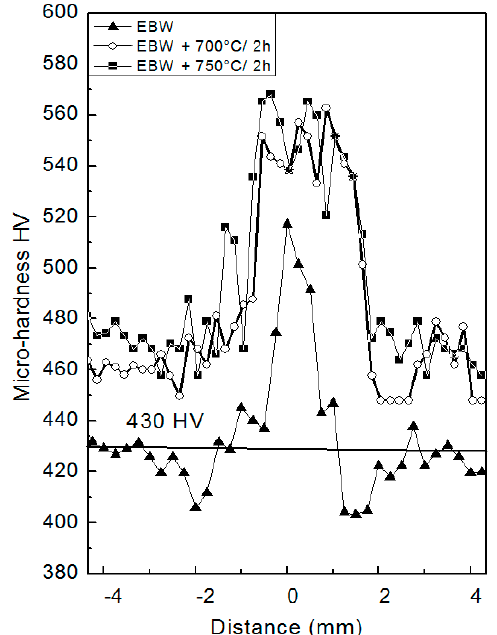
Figure 15. Micro-hardness profiles across a joint realized with PHT = 300 °C and pass speed v = 2.5 m/min. Three different conditions are compared: as-welded, after PWHT at 700 °C for 2 h, and after PWHT at 750 °C for 2 h.